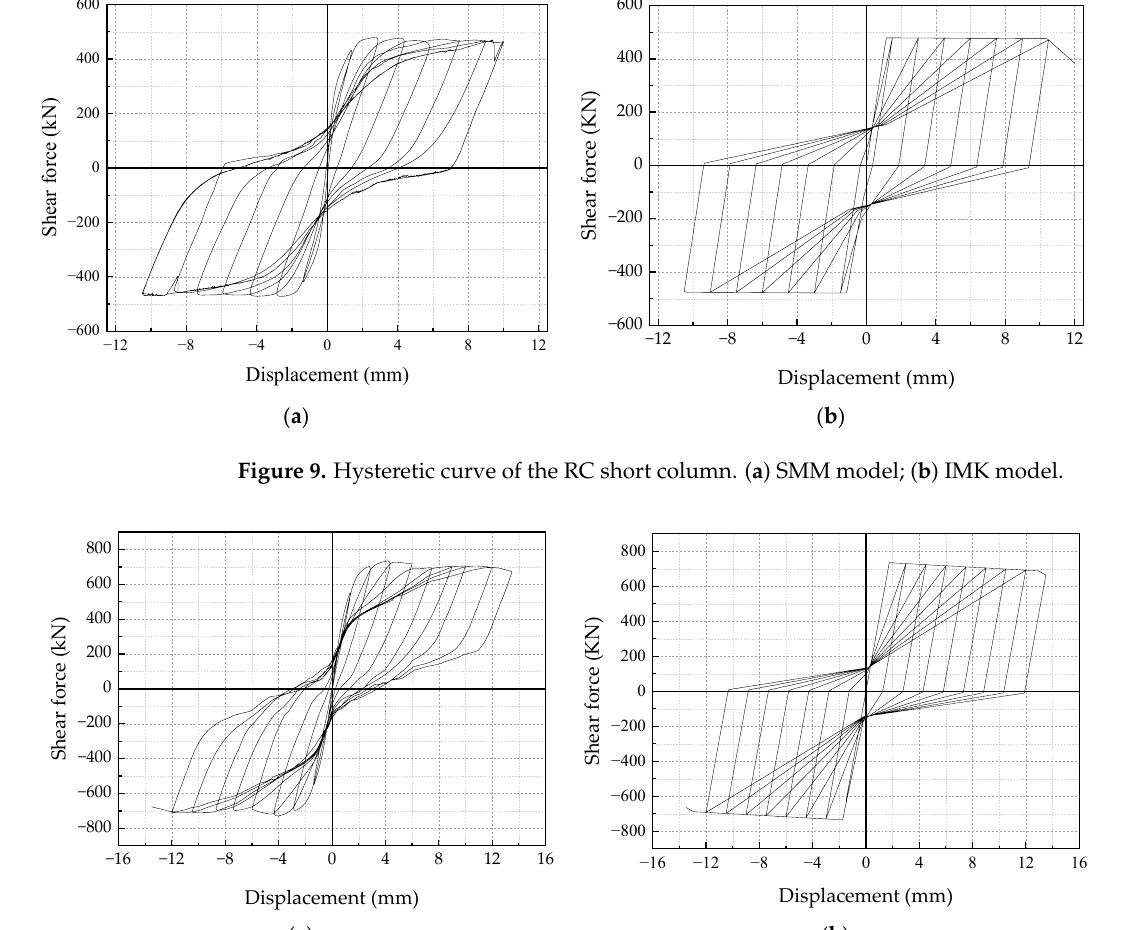
Figure 8. Skeleton curves of the RC short column and ECC short columns simulated by two models.